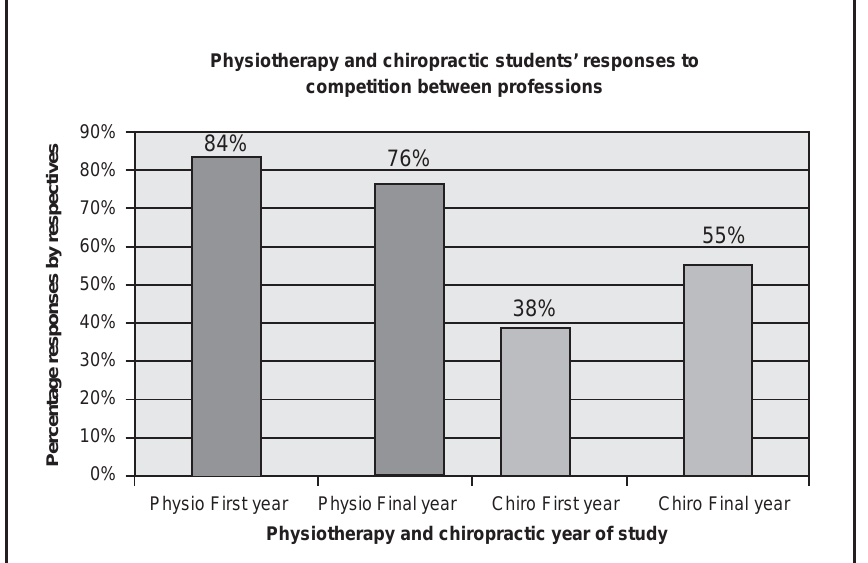
Figure 2: Graph showing the percentage of each class who perceived physio therapy and chiropractic to be in direct